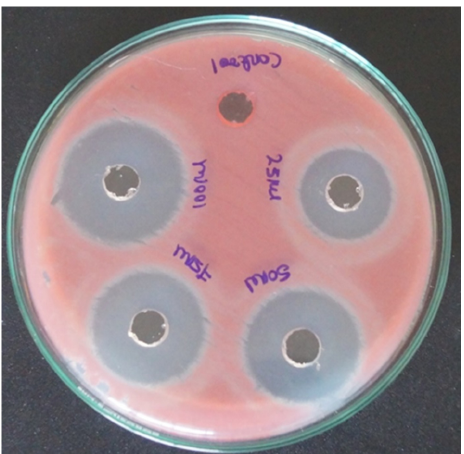
Figure 5. Antibacterial activity of selenium nanoparticles synthesized using D. indica on Se. marcescens (MTCC4822).